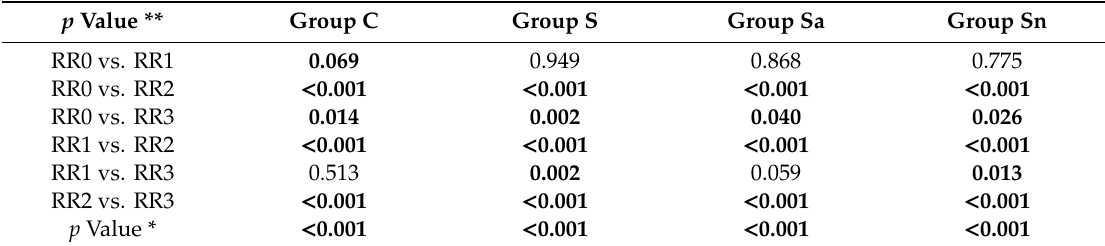
Table 3. Inter-time comparison of RR intervals in ECGs on admission to the hospital and during three phases of HUTT.